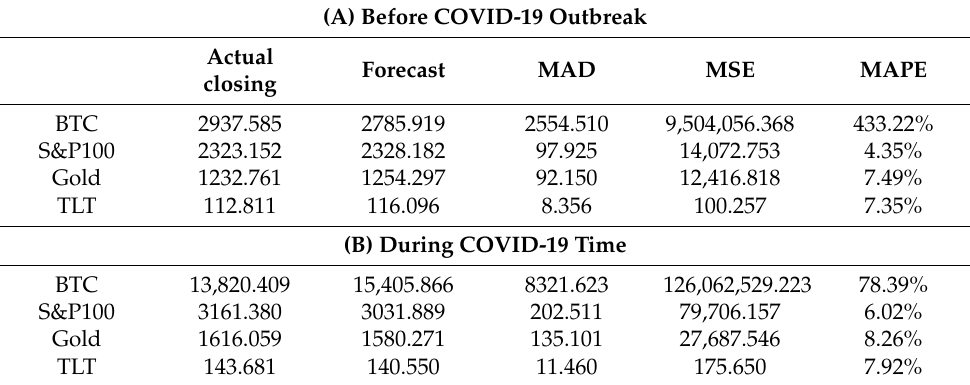
Table 4. Evaluation indicators of all financial assets before and during COVID-19.